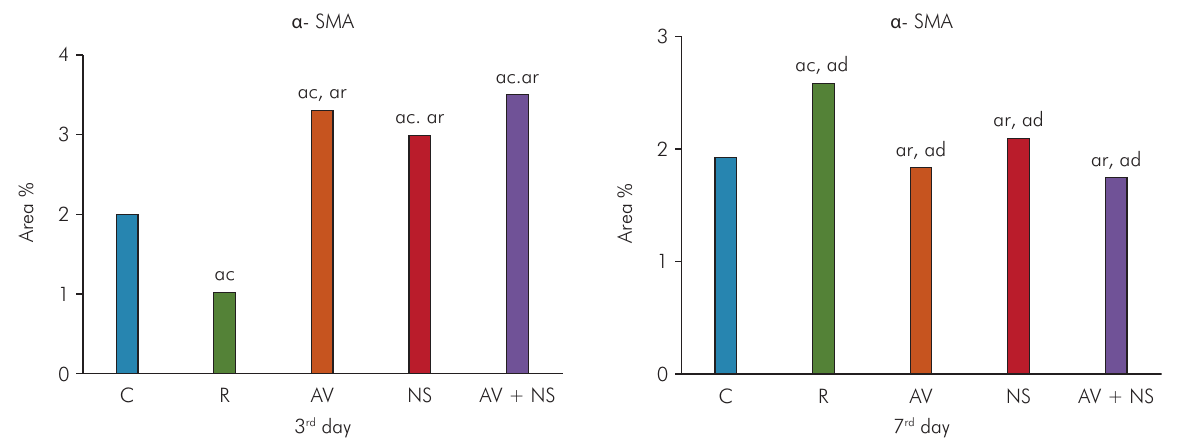
*Significant difference between groups: (ac) versus control group, (ar) versus irradiated group. Significant difference between same group (ad) at 3 rd day. Figure 4. Area percent of activated fibroblasts and mature vascular endothelial cells expressing α -SMA in ulcer area is shown at (A) 3 rd day and (B) 7 th day